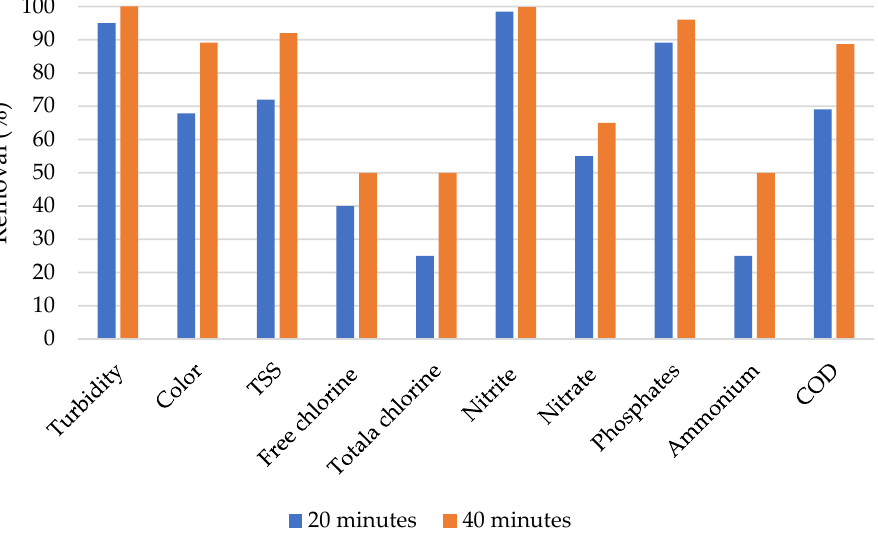
Figure 5. Removal efficiencies from the Al–Gr electrode combination.